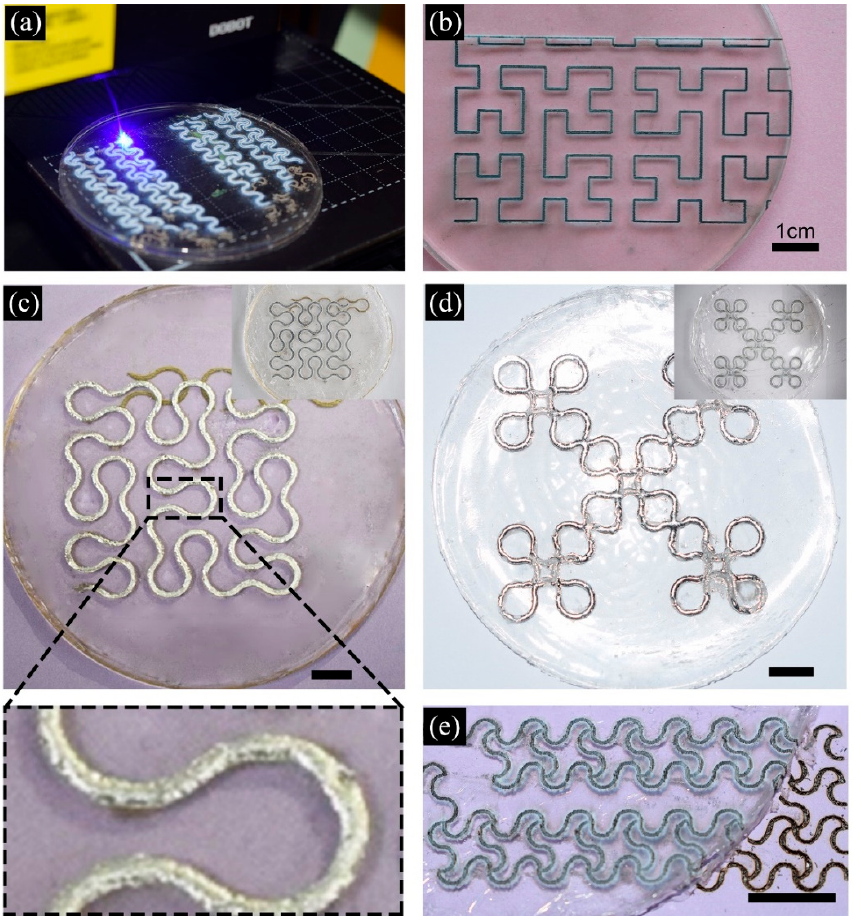
Figure 2. ( a ) Laser Engraving of Golden Serpentine Patterns. ( b ) Peano curve in laser engraving. ( c ) Peano-based wire before and after filling liquid metal. ( d ) Vicsek fracta on PDMS. ( e ) Gold serpentine patterns carved on paper bases and PDMS. (In ( c – e ), the scale is 1 cm)